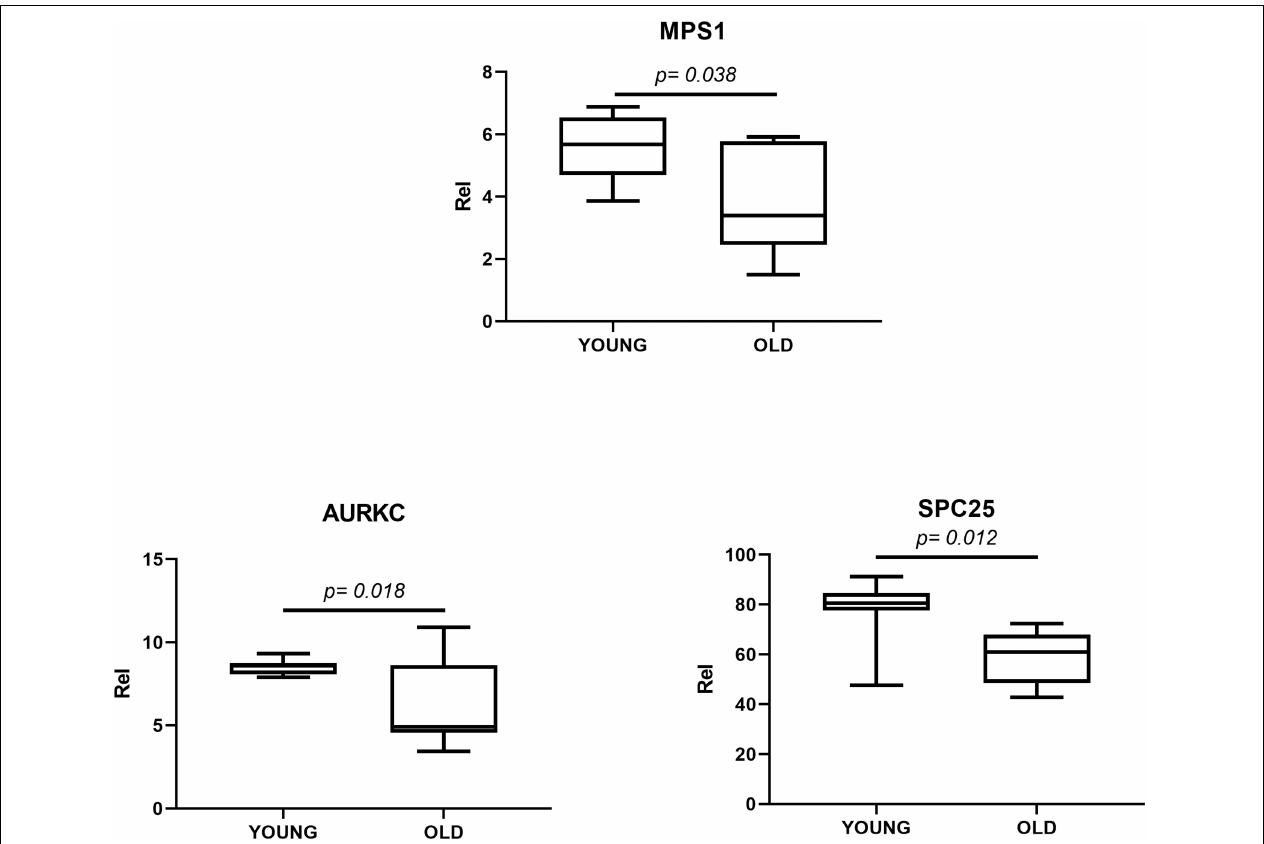
FIGURE 2 | mRNA expression for Mps1 , Spc25 and AurkC in oocytes from young ( ≤ 14 years) and old ( ≥ 16 years) mares. The box plot shows the interquartile range, with the median value indicated by the horizontal line; whiskers show the range.